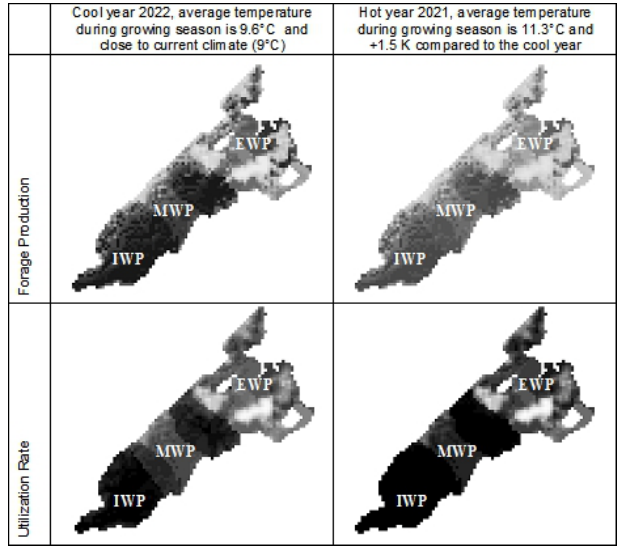
Fig. 5 . Output maps of forage production and local utilization rate (percentage consumed forage) in two arbitrarily chosen years—a hot one (2021) and a cool one (2022), based the moderate climate change scenario B2 with contrasting average temperatures in the vegetation period ( D 1.5 K). Darker tones indicate higher values of the respective